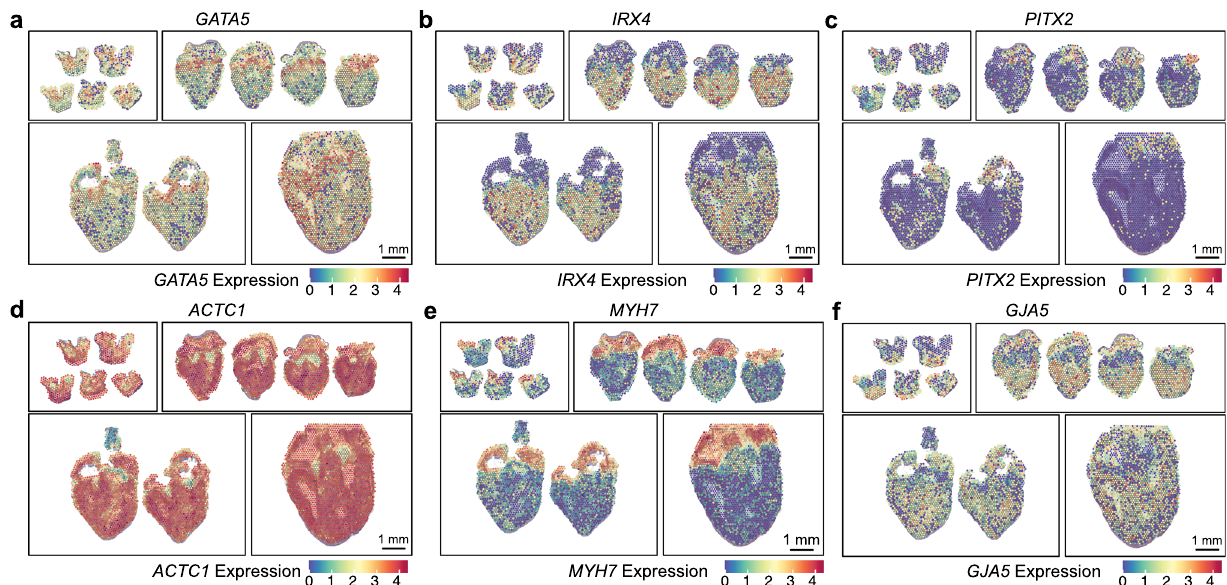
Fig. 4 Spatially resolved gene expression for congenital heart disease (CHD) associated genes. a GATA5 , ( b ) IRX4 , ( c ) PITX2 , ( d ) ACTC1 , ( e ) MYH7 , and ( f ) GJA5